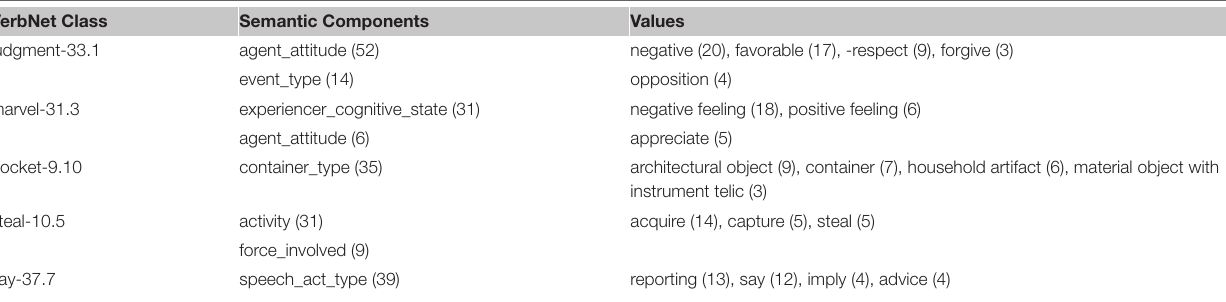
TABLE 5 | Five of the VerbNet classes having between 51 and 100